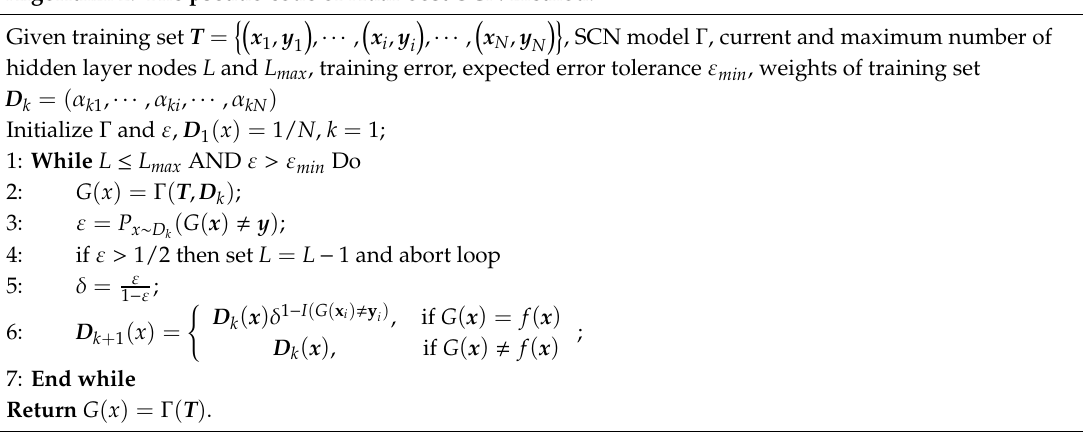
Algorithm 2: The pseudo code of AdaBoost-SCN method.